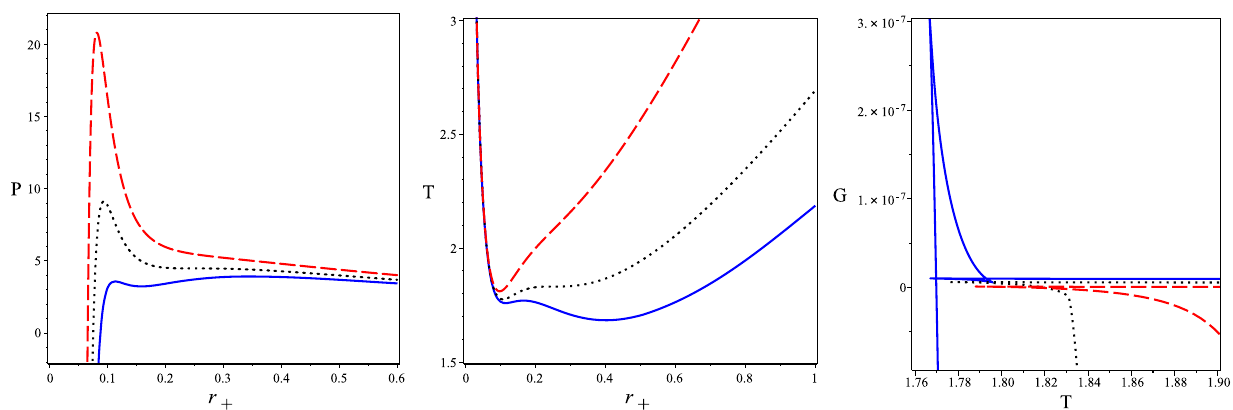
= 2 . 74376 , r = 0 . 131663 , T = Fig. 24 RPT of spherical black holes: P − r + (left), T − r + (middle) (dashed lines). Critical data: ( P c c 2 c 2 2 = 4 . 47518 , r = 0 . 249414 , T = 1 . 83107 ) , ( P (cid:5) and G − T (right) diagrams; we have set k = 1, d = 10, q = 0, 1 . 74384 ) , ( P c c 1 c 1 tr 1 m = 0 . 1, c 0 = 1, c 1 = − 9, c 2 = − 2, c 3 = − 1, c 4 = 0 and α = 0 . 01. 3 . 93852 , T tr (cid:5) 1 . 76669 ) , and ( P z (cid:5) 3 . 96314 , T z (cid:5) 1 . 76709 ) . Note: < T < T = T Left panel: T c The values of Gibbs free energies in the G − T diagram (continuous and c 1 (continuous line), T c 1 (dotted line) 2 < P < P dashedlines)havebeenslightlyshifteduptoavoidisobariccurvesover- and T > T c (dashed line). Middle panel: P c c 1 (continuous 1 2 lap with each other. The corresponding behavior of the heat capacity lines), P = P c (dotted lines) and P > P c (dashed lines). Right panel: 1 1 P tr < P < P z (continuous lines), P = P c near the virtual triple point ( P tr ) is depicted in Fig. (dotted lines) and P > P c 1 1